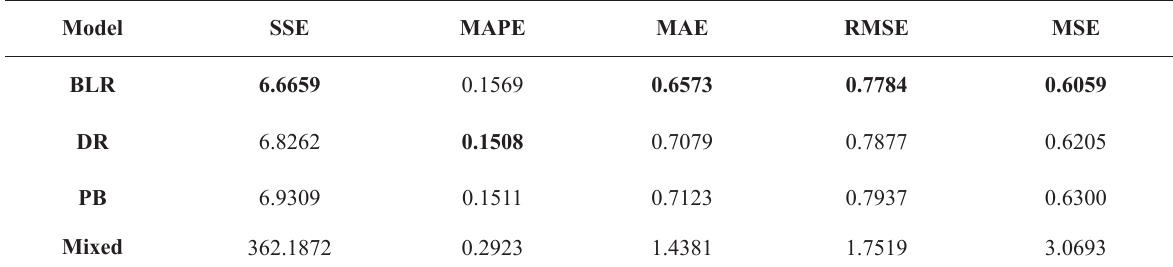
Table 4: Estimated SSE, MAPE, MAE, RMSE, and MSE values computed using five fitted models. Model